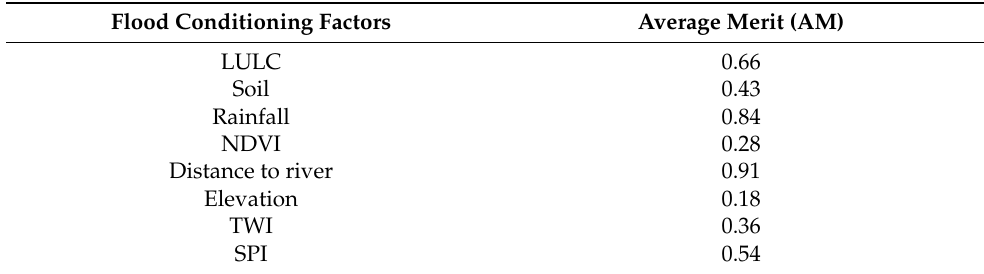
Table 4. Relative importance of flood causative